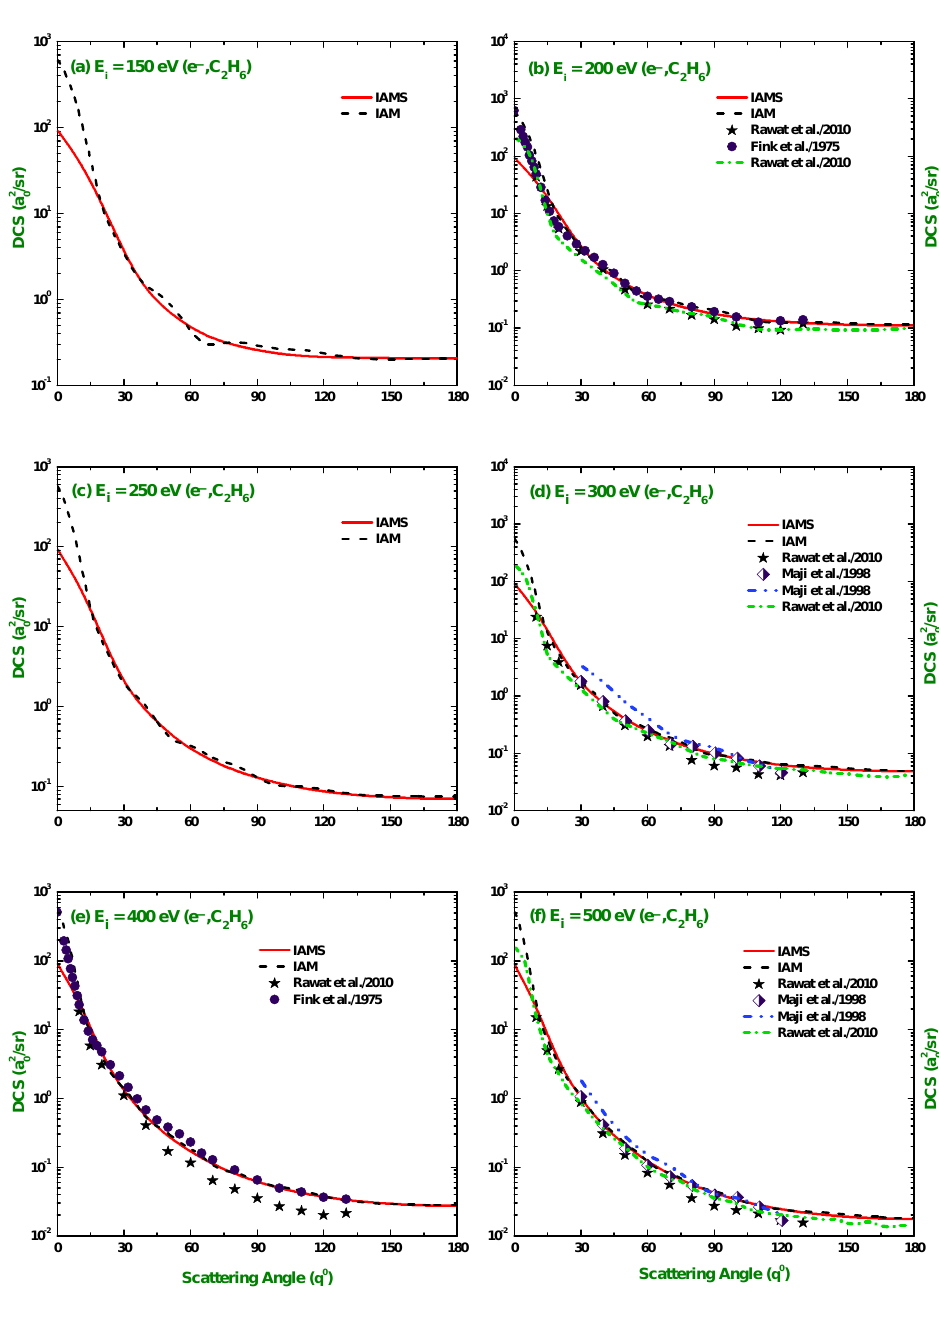
Figure 2. DCS ( a 2 / sr ) for the elastic scattering of electrons from C 2 H 6 at energies of 150, 200, 250, 0 300, 400, and 500 eV. Theoretical works: References in Figure 1 and Maji et al. [27]; Experimental works: References in Figure 1 and Maji et al.